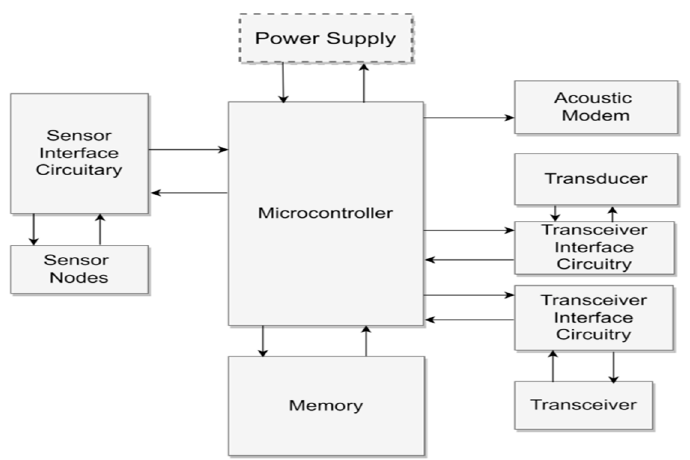
Figure 2. 3D- Visualization of underwater wireless communication.